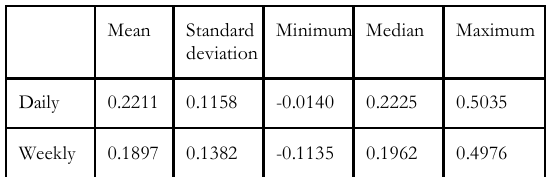
Table 7: Statistics summary for correlations of between Bitcoins and